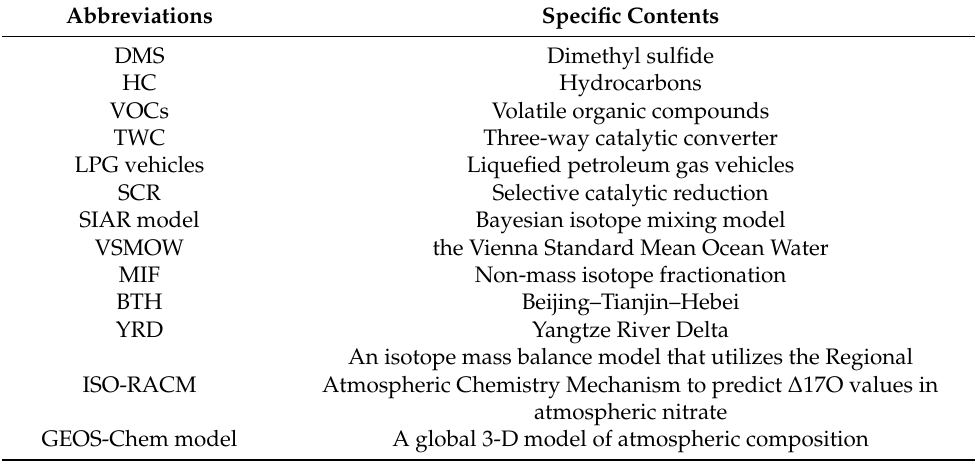
Table 2. List of